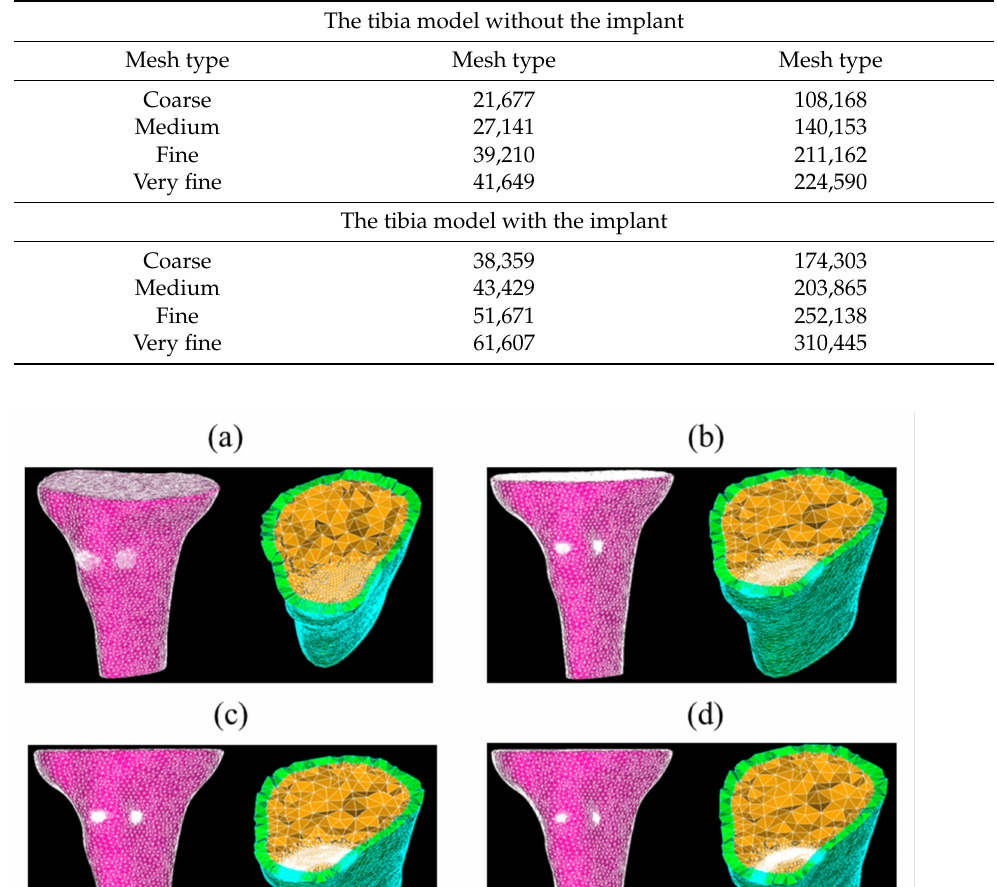
Table 2. Different mesh configurations for the case of the tibia bone with and without the implant.